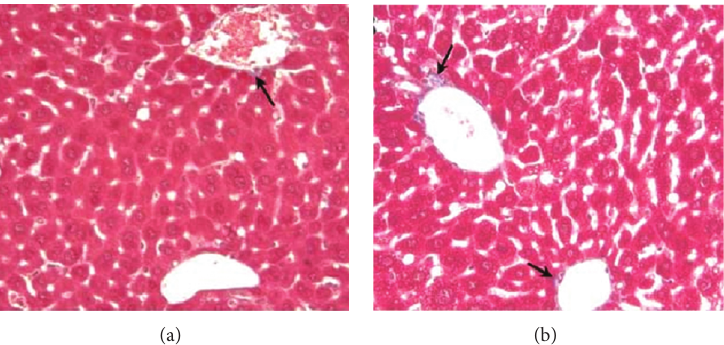
Figure 2: Representative images of Masson’s Trichrome Stain. Collagen deposits (→) are examined on liver sections at 60x magnifications. Calorically restricted liver (a) exhibits less collagen deposits than liver of ad libitum fed animal (b); animal age is 14 months.